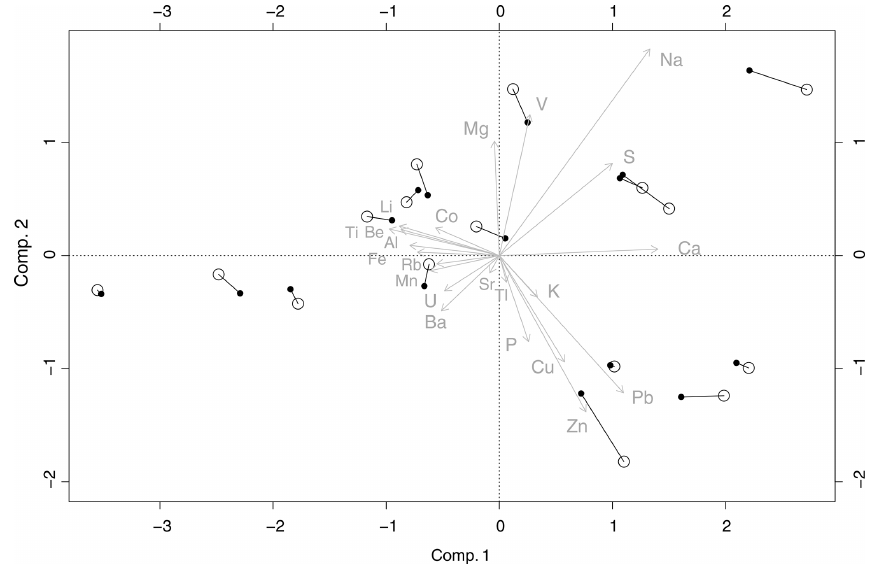
Figure 7. Biplot for the two sampling devices (all elements except REEs). PM10 samples are figured with circles, and solid discs represent VTD samples. Lines between PM10 and VTD symbols link paired samples. Percentages of variability explained by the first two components are 61% and 16%, a total of 77%.